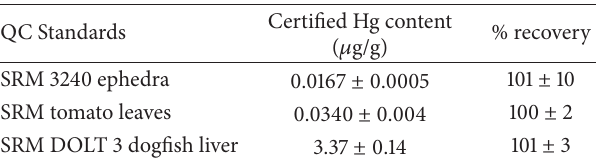
Table 5: Analysis of standard reference materials (SRMs) by the Hydra C for Hg.